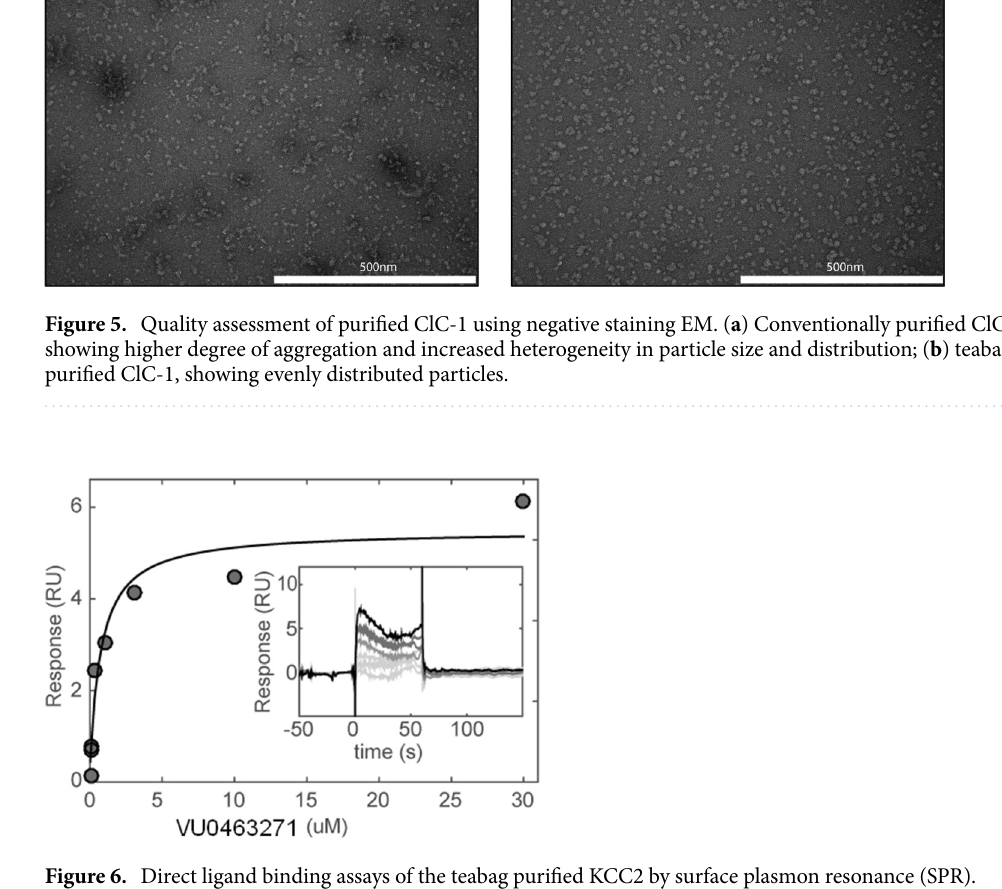
Figure 6. Direct ligand binding assays of the teabag purified KCC2 by surface plasmon resonance (SPR). Concentration–response and corresponding Langmuir steady state fit of VU0463271 injected onto covalently immobilized KCC2. Inset: sensorgram of binding of (from bottom to top) 0, 0.1, 0.3, 1, 3, 10, 30 µM